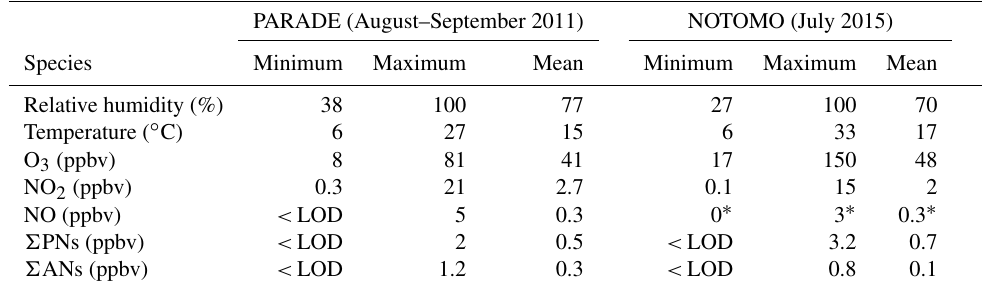
Table 2. Minimum, mean, and maximum values for relative humidity, temperature, ozone, NO, NO 2 , and organic nitrates during the PA- RADE and NOTOMO campaigns.